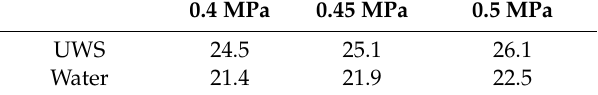
Table 3. Initial jet velocity in m / s for water and UWS for all considered injection pressures